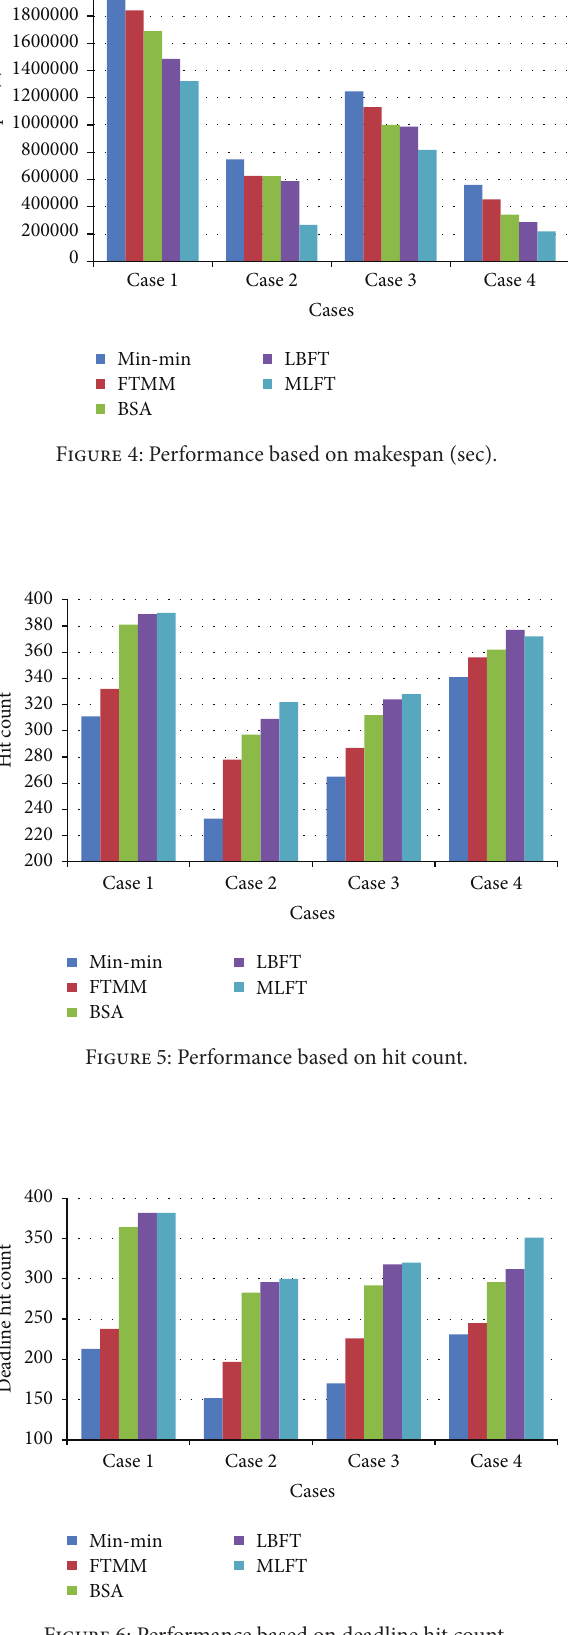
Figure 6: Performance based on deadline hit count.